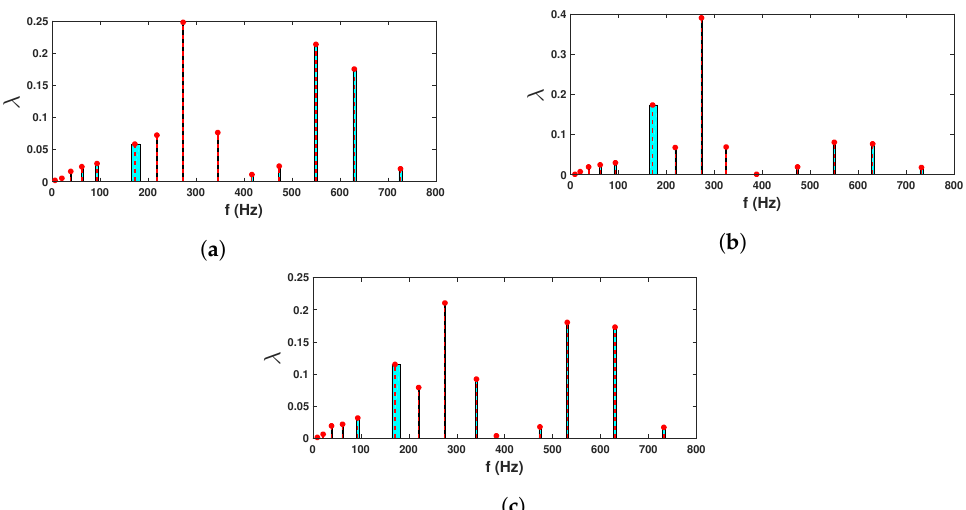
Figure 12. Clustering of beam test data from different sensors; ( a ) sensor 1, ( b ) sensor 2 & ( c ) sensor